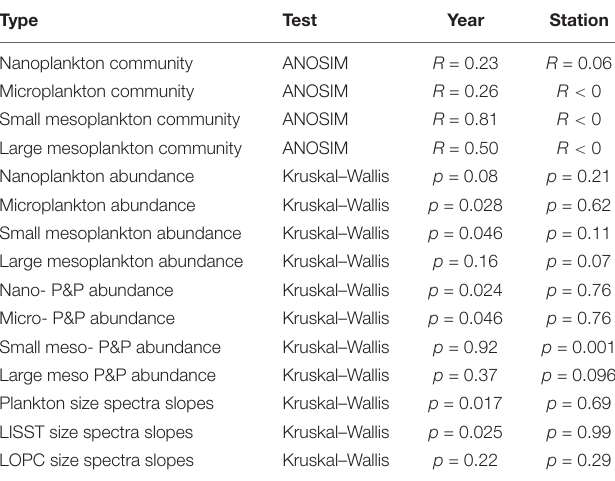
TABLE 1 | The results of ANOSIM and Kruskal–Wallis tests provided for all plankton size fractions and studied years/stations together with the slopes of plankton size spectra derived from LISST and